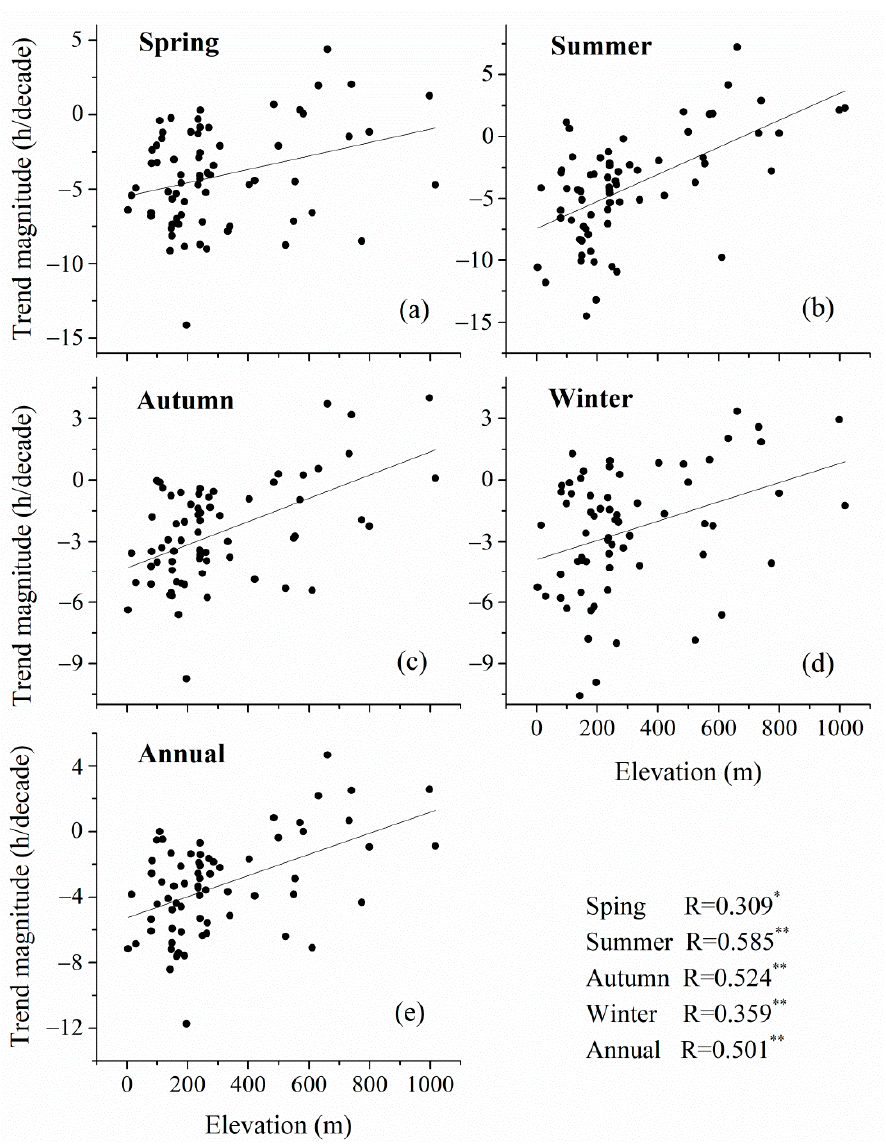
Figure 5. The relationship between the sunshine duration trend and elevation at seasonal ( a – d ) and annual ( e ) scales in northeast China during 1961–2015. “SD” represents sunshine duration. * Significant at p < 0.05, ** Significant at p < 0.01.